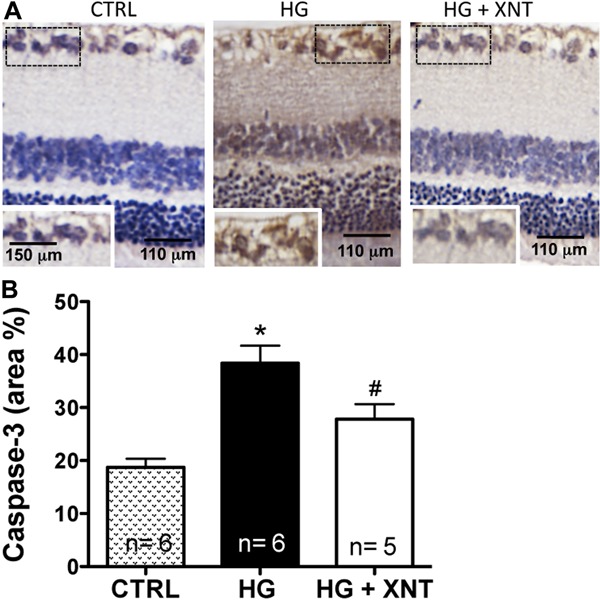
Effects of XNT on caspase-3 expression in retinal ganglion cells (RGC).
A, Representative photomicrographs of retinas of control
rats (CTRL), hyperglycemic untreated rats (HG) and hyperglycemic treated rats
(HG+XNT) showing higher caspase-3 expression in RGC of the HG group (see
insets). Rectangular dotted lines delineate the amplified areas shown in the
inset images. B, When the expression of caspase-3 was
quantified, XNT reduced the apoptosis of RGC of HG rats. *P<0.05 compared to
CTRL group; #P<0.05 compared to HG group (one-way ANOVA followed
by the Newman-Keuls test).